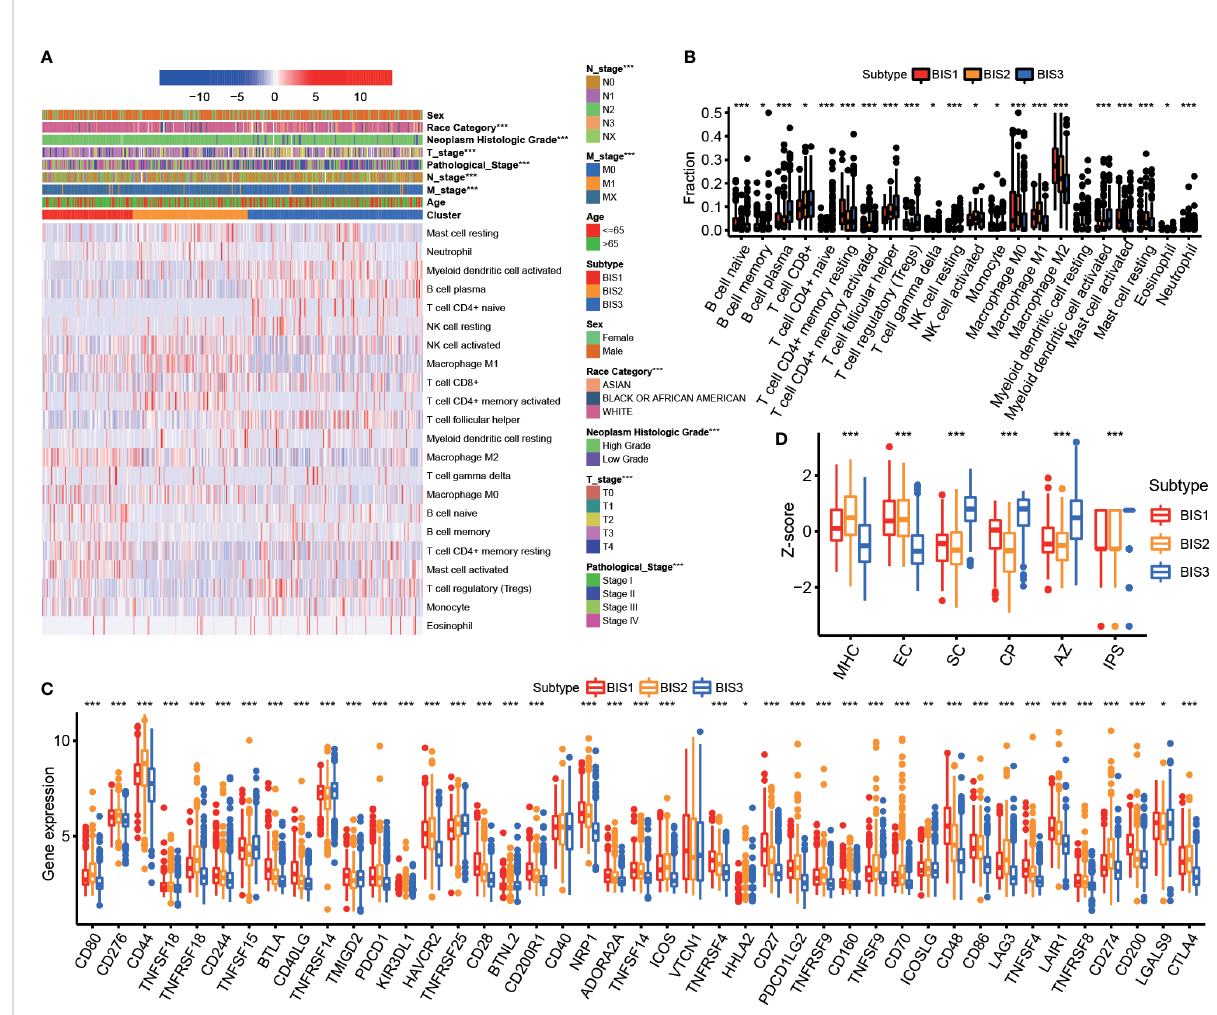
FIGURE 5 Immune characteristics of three subtypes. (A) Heatmap of immune cell fraction among three subtypes in TCGA BLCA cohort. (B) Boxplot of immune cell fraction among three subtypes in TCGA BLCA cohort. (C) Immune checkpoint of three subtypes in Meta cohort. (D) Immunophenogram for the visualization of the parameters determining immunogenicity. Boxplot showed the immune score of three subtypes in TCGA BLCA cohort (MHC, major histocompatibility complex-related molecules; EC, effector cells; SC, suppressor cells; CP, checkpoints or immunomodulators; AZ, averaged z-score; IPS, immunophenoscore). *P < 0.05, **P < 0.01, ***P <